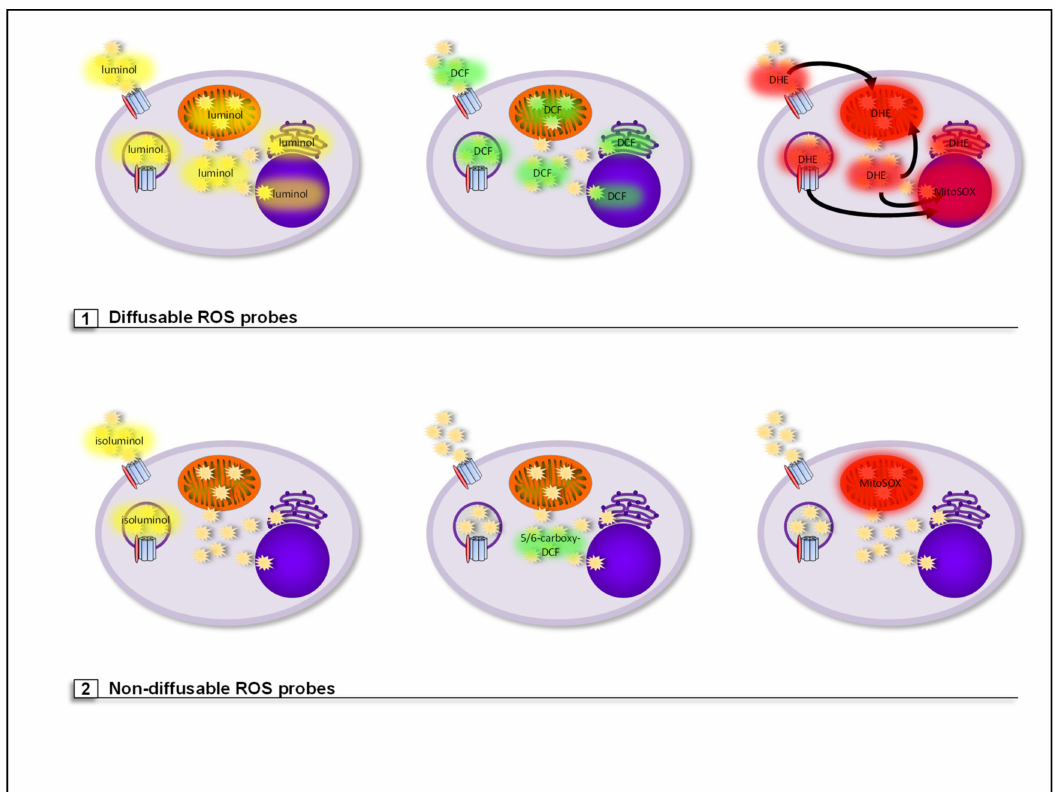
Figure 7. ( 1 ) Diffusible ROS probes are not retained or targeted to a specific cellular compartment. Luminol is a luminophore that reacts with all types of ROS. Luminol-based chemiluminescence represents a quantitative value for the amount of ROS generated but since this probe is diffusible, both extra- and intracellular ROS, i.e., total cellular ROS, are detected. H 2 DCF-DA is a cell-permeable derivative of fluorescein and one of the most commonly used ROS probes. H 2 DCF-DA is often referred to as intracellular ROS probe. However, it is diffusible and therefore does not only remain in the cytosol but also reaches cell organelles and diffuses back into the extracellular space. Therefore, like with luminol, only total cellular ROS can be detected with this probe. DHE is a red fluorescent probe that rather specifically reacts with cellular O 2 •− resulting in red fluorescence. However, it easily crosses cellular membranes and therefore can be oxidized by O 2 •− anywhere in and outside of the cell. Therefore, with this probe only total cellular O 2 •− production can be detected. Oxidation of DHE generates two products, 2-hydroxyethidium and ethidium. Both products bind to DNA, which highly increase their fluorescence. This may lead to false interpretations regarding the localization of ROS production, namely DNA containing organelles such as the nucleus and mitochondria, when fluorescence microscopy is used to analyze ROS production. ( 2 ) Some ROS probes are either cell-impermeable, targeted to or retained in a specific cellular compartment. Isoluminol is a cell-impermeable derivative of luminol. This makes it ideal for exclusive measurement of extracellular ROS, which also includes ROS produced into the lumen of endosomes and phagosomes. 5/6-Carboxy-DCF is a derivative of H 2 DCF-DA that contains two additional carboxyl groups that enhance its hydrophilicity and therefore strongly increase its retention in the cytosol. Therefore, 5/6-Carboxy-DCF can be used to specifically detect cytosolic ROS levels. MitoSOX is accumulated in the mitochondrial matrix and specifically detects O 2 •−